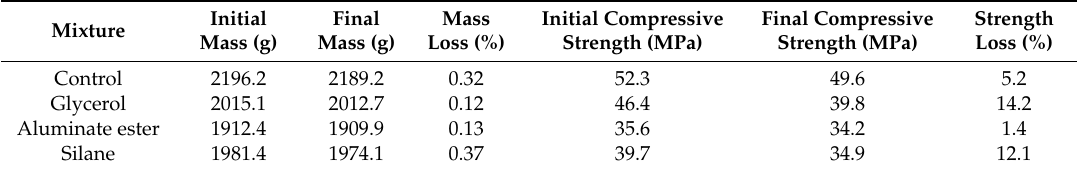
Table 7. Mass loss and compressive strength loss after 25 freeze–thaw